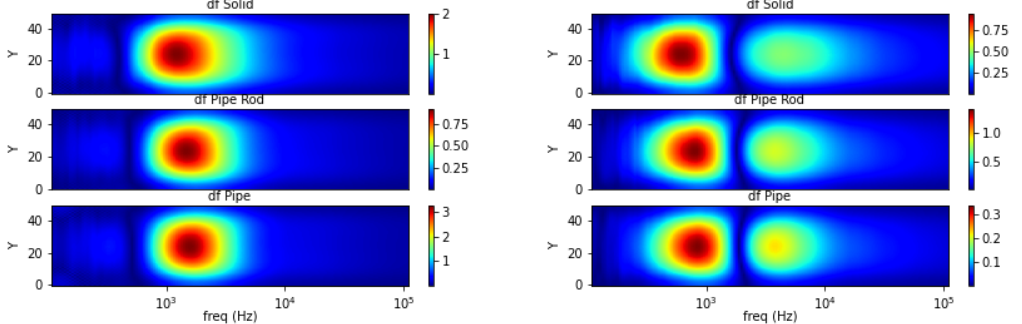
Figure 20. Z ( left ) and θ ( right ) spectral gradient (df) metallic structures.